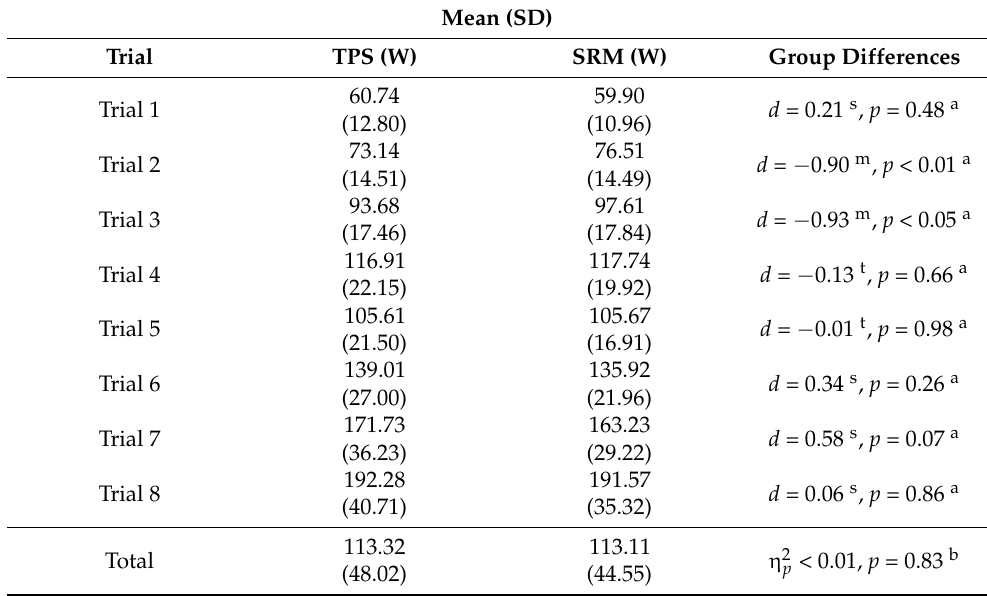
Table 3. Comparison of trial 1-minute average by